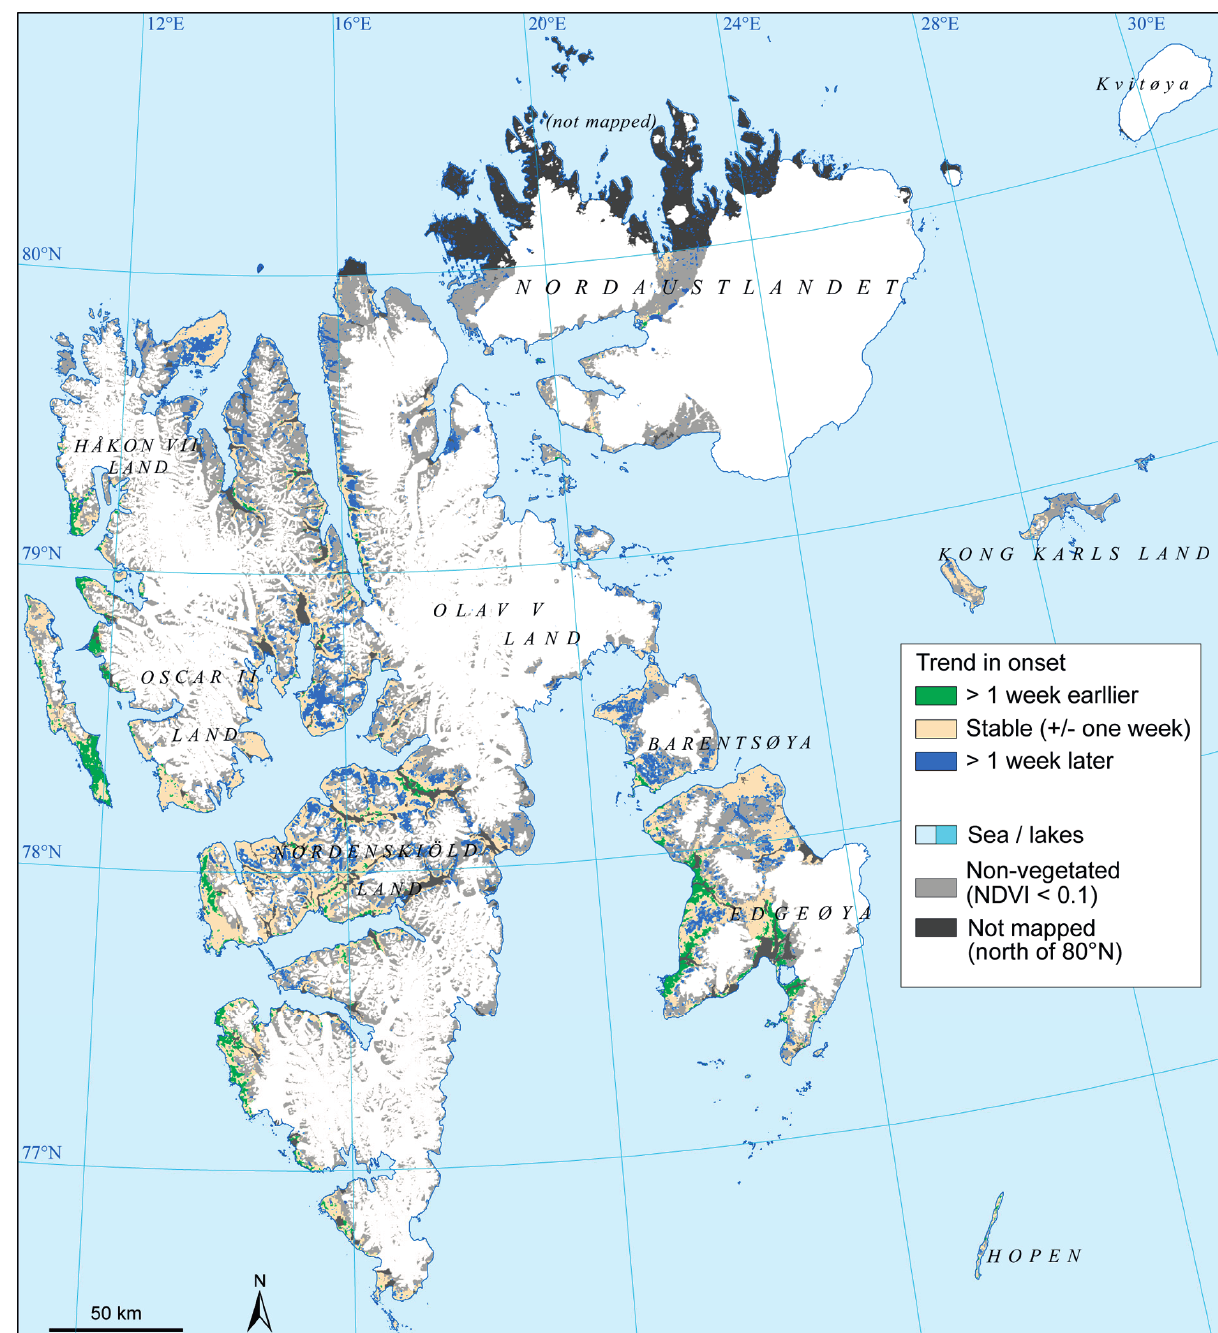
Figure 8. Number of days of the earlier start of growing season on Svalbard in 2013 compared to 2000 assuming a linear